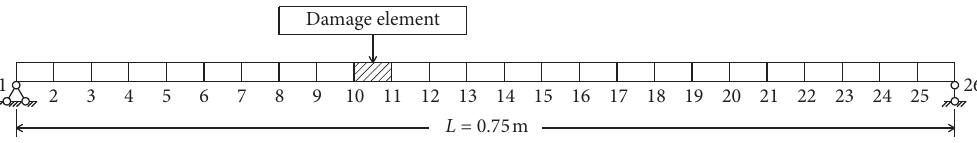
Figure 2: Schematic diagram of a simply supported beam with single damage.